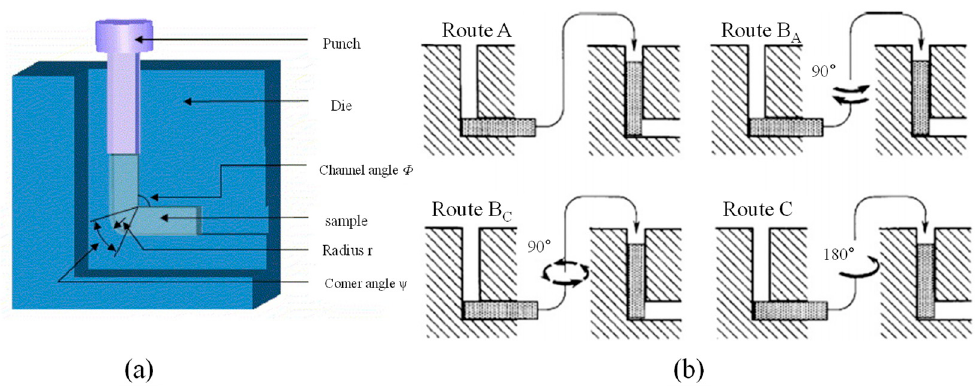
Figure 1. ( a ) Working principle of ECAP [24]. Reproduced with permission from Elsevier B.V. ( b ) Schematic diagram of different routes [17]. Reproduced with permission from Elsevier Ltd.